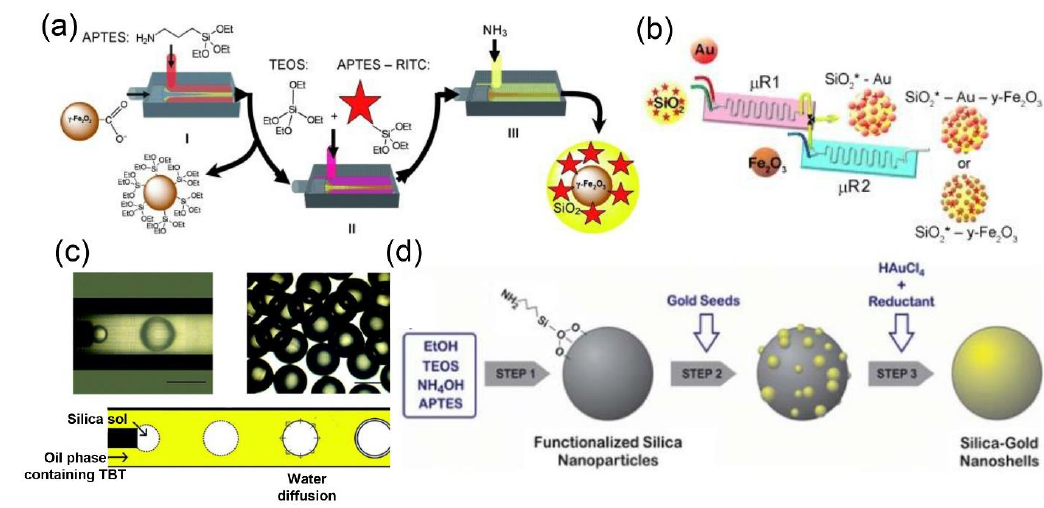
Figure 2. ( a ) Scheme for the continuous synthesis of core-shell structured Fe 2 O 3 -SiO 2 nanoparticles (reproduced from [86], with permission from the Royal Society of Chemistry, 2009). ( b ) A two-step microfluidics-based synthesis procedure for the assembly of multifunctional SiO 2 -Au-Fe 2 O 3 nanoparticles (reproduced from [87], with permission from the American Chemical Society, 2013). ( c ) Micrographs of the droplets and the mechanism of the synthesis of core–shell structured particles (reproduced from [85], with permission from the Royal Society of Chemistry, 2011). ( d ) Experimental process and set-up for the continuous synthesis of SiO 2 -Au nanoshells (reproduced from [88], with permission from the Royal Society of Chemistry, 2012).